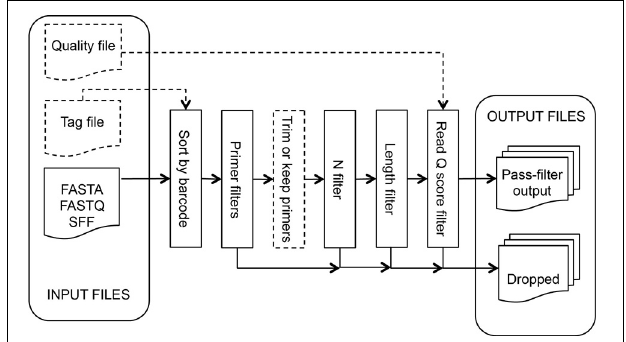
FIGURE 1 | Inputs, outputs, and the filters applied, in order, by Initial